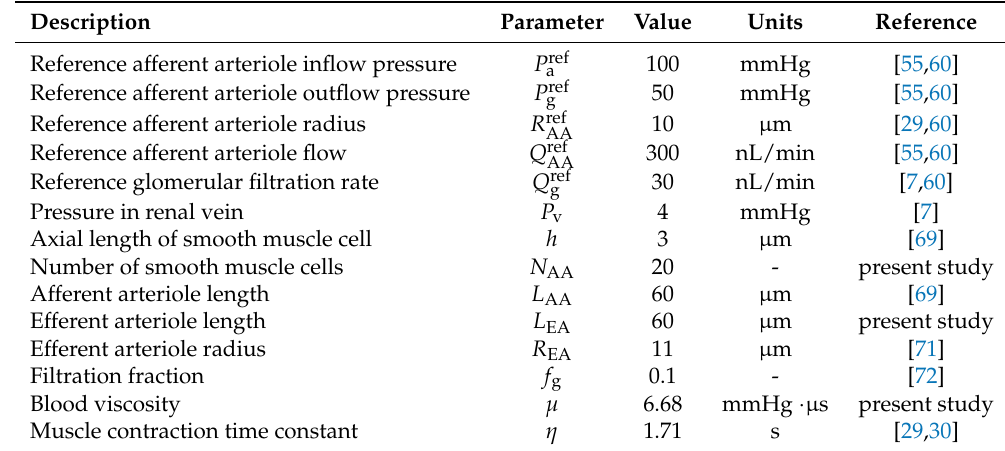
Table 1. Model parameter